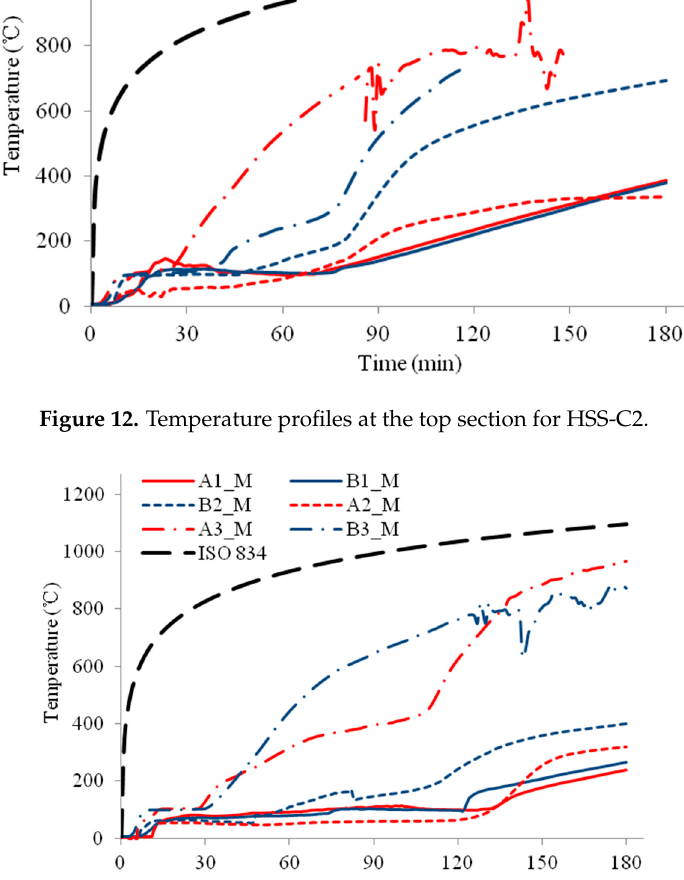
Figure 13. Temperature profiles at the medium section for HSS-C3.